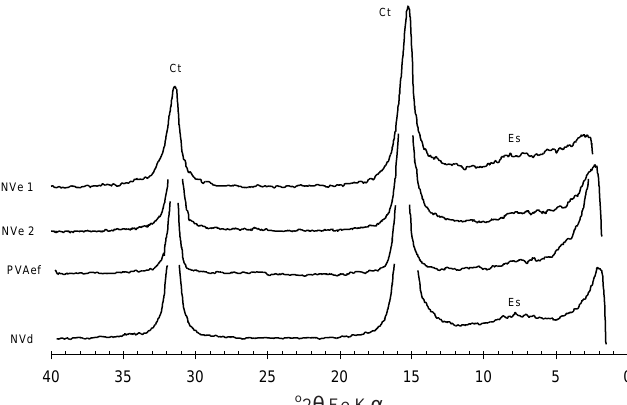
Figura 6. Difratogramas de Raios-X da fração argila desferrificada dos solos com horizonte Bt Tb ou Bn estudados (lâminas de argila orientada). Ct – Caulinita; Es – Esmectita.